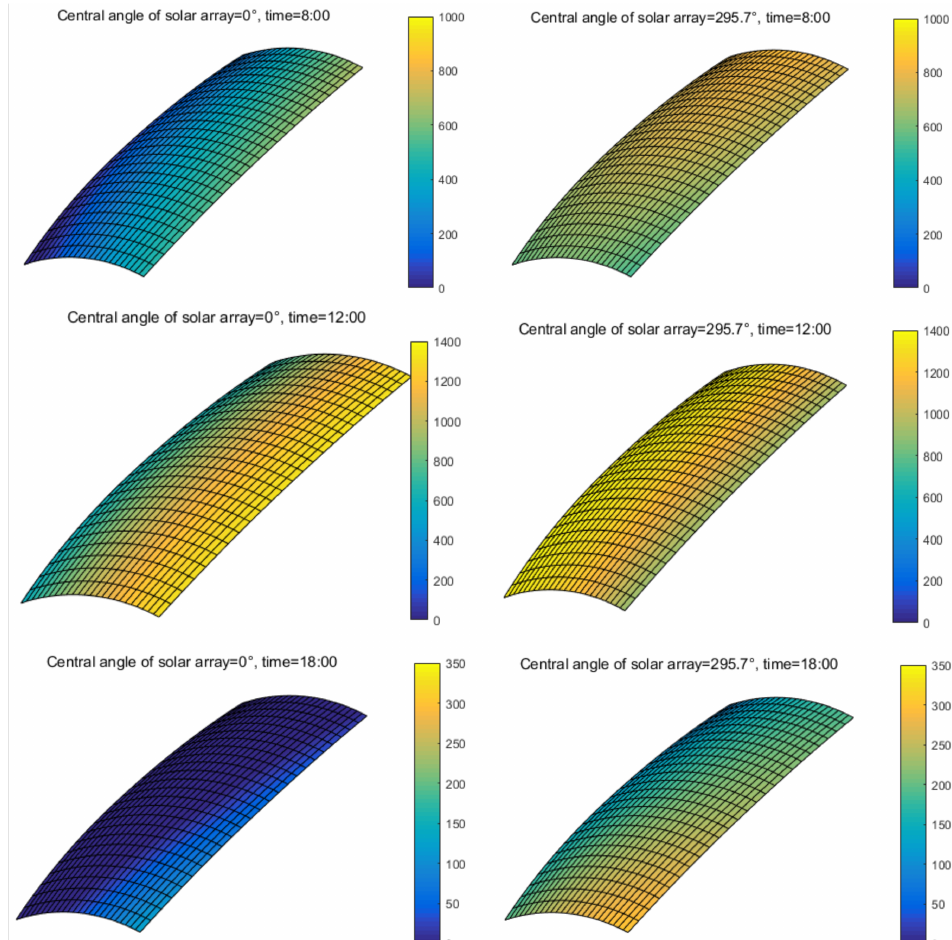
Figure 11. Comparison of instantaneous direct solar radiation distribution on the solar array for central angle θ 0 = 0 ◦ (traditional configuration) and θ 0 = 295.7 ◦ (optimized